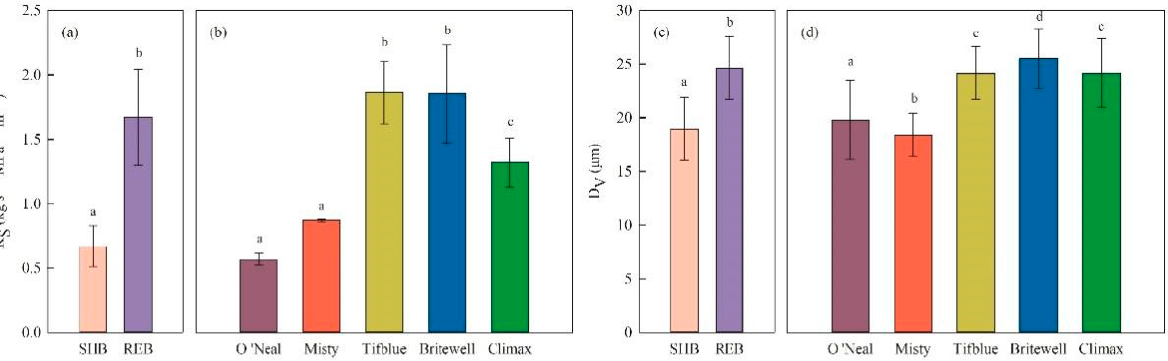
Figure 2. Comparison of sapwood hydraulic conductivity (K S , ( a , b )), vessel diameter (D V , ( c , d )), wood density (WD, ( e , f )), vessel-grouping index (VG, ( g , h )), vessel density (VD, ( i , j )), and pit mem- brane thickness (T PM , ( k , l )) in five cultivars belonging to southern highbush and rabbiteye blueber- ries. SHB data represent the means of two southern highbush blueberry cultivars, including O’Neal and Misty, and REB data represent the means of three rabbiteye blueberry cultivars, including Britewell, Climax, and Tifblue. Different lowercase letters indicate statistically significant differ- ences in traits among cultivars ( p < 0.05), while same lowercase letters represent no significant dif- ferences in traits among cultivars ( p > 0.05). 3.2. Differences in Xylem Anatomical Traits Anatomical observations showed that the xylem structure of five blueberry cultivars varied at different scales. Vessel diameter (D V ) of SHB (18.95 ± 2.91 µm) was significantly smaller than that of REB (24.61 ± 2.95 µm) ( p < 0.01; Table S1; Figure 2c). However, vessel density (VD), wood density (WD), conduct wall reinforcement (CWR), and vessel-group- ing index (VG) were all greater in the SHB than in the REB (Figure 2e – h; Table S1). All five blueberry cultivars showed bordered pits. Although pit density (PD) was significantly greater in SHB than in REB, the single pit aperture area (A SP ) was signifi- cantly smaller than in REB (Table S1). Similarly, the total area of inner pit aperture (A PA ) of SHB (0.14 ± 0.04 µm 2 ) was significantly smaller than that of REB (0.34 ± 0.04 µm 2 ) ( p = 0.02; Table S1). Besides, two types of pit membranes in inter-vessel pits or vessel-tracheid pits were found in all five cultivars. One type only showed a straight and homogeneous outlook lying in the middle of a pit (Figure 3a,b), while the other type showed pseudo- tori with torus-like thickenings arching in the middle of a pit membrane (Figure 3a,c). The thickness of the pit membrane (without pseudo-tori) in SHB (486.59 ± 102.64 nm) was